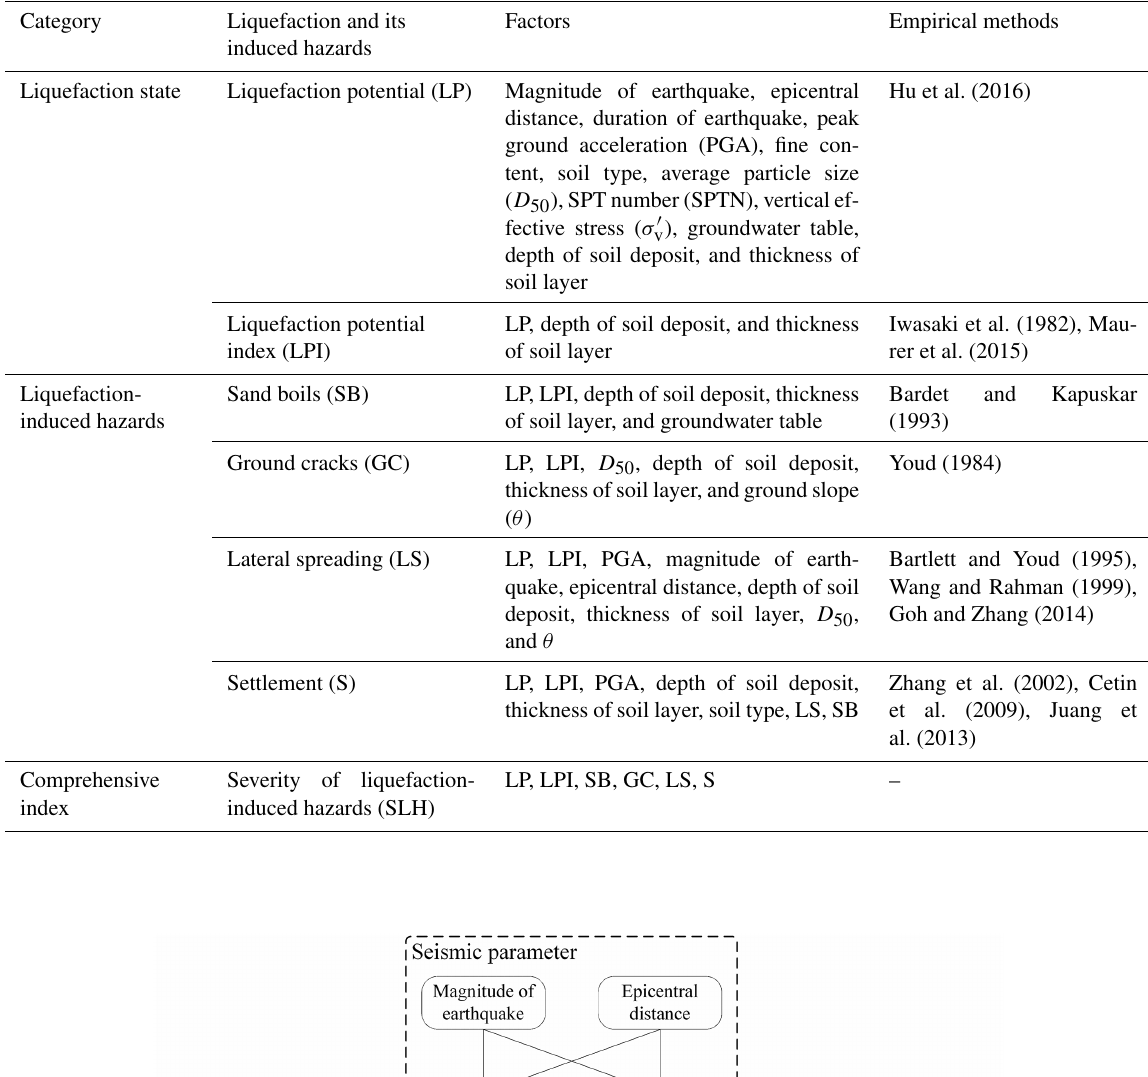
Table 1. Factors of liquefaction and its induced hazards and empirical modelling methods.